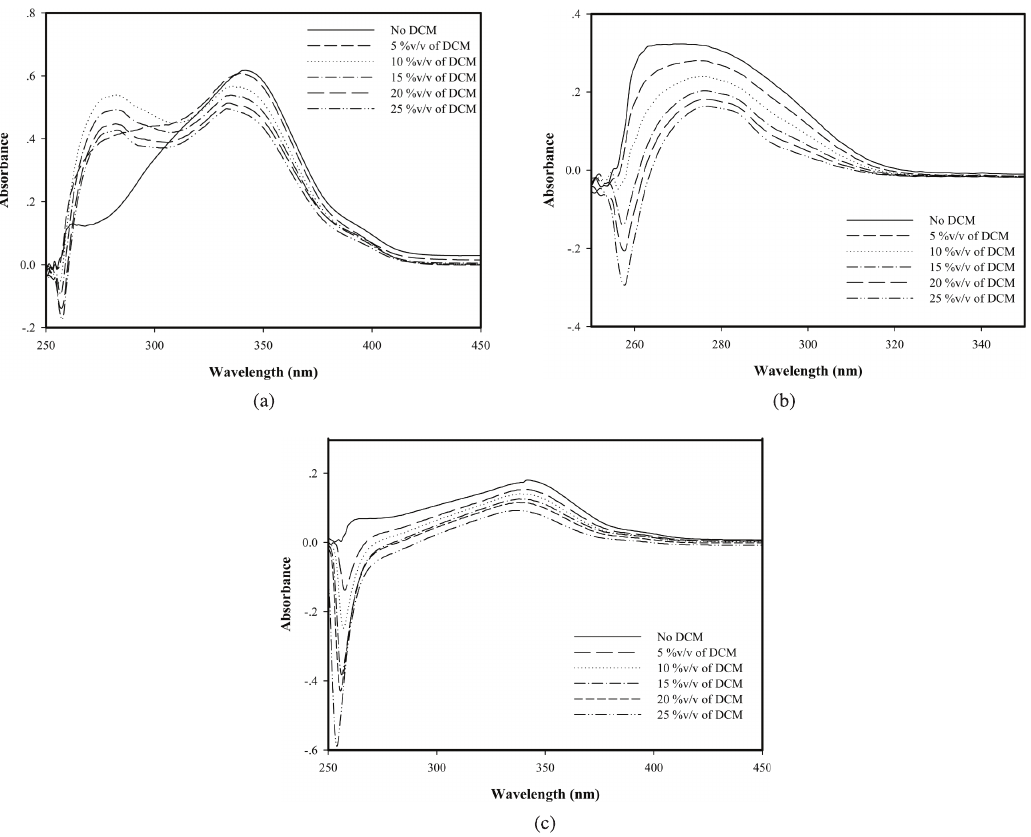
Figure 8. UV-Vis spectra of: a) D-PDPA; b) Y_H + when exposed to DCM; and c) D-PDPA/30%Y_H + [80] composite at various